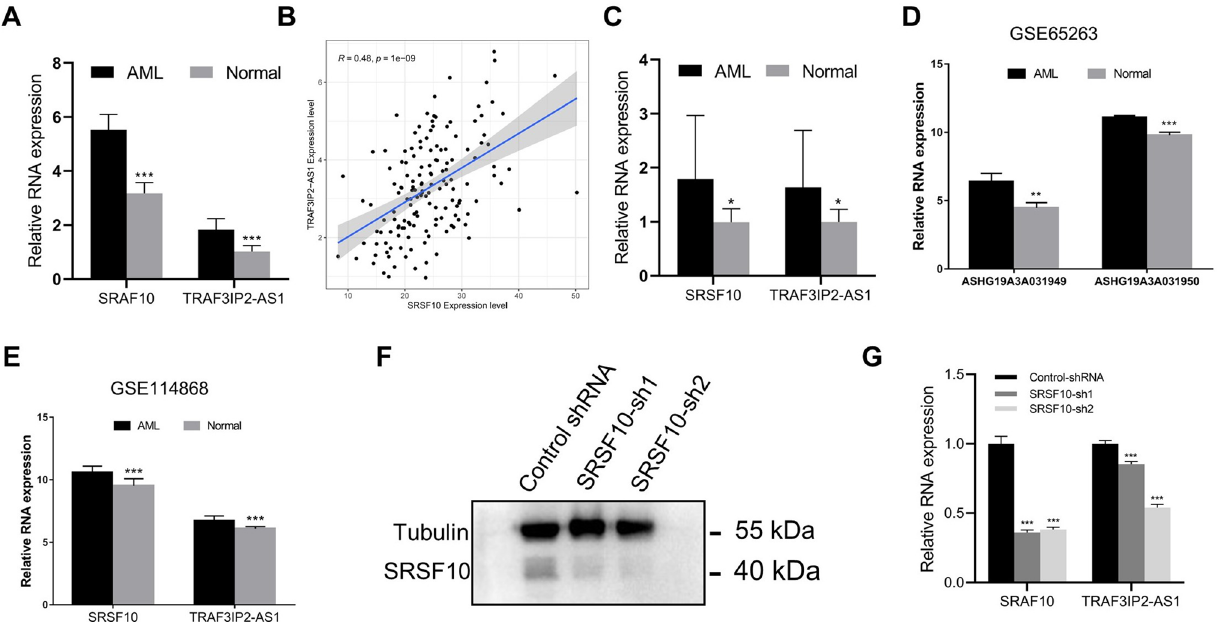
Figure 12. Interaction between SRSF10 and TRAF3IP2. ( A ) The levels of expression of SRSF10 and TRAF3IP2-AS1 in AML samples from the TCGA databases and normal samples from the GTEx databases. ( B ) Correlation analysis between SRSF10 and TRAF3IP2-AS1 in AML samples from the TCGA database. ( C ) The expression levels of SRSF10 and TRAF3IP2-AS1 in AML peripheral blood samples (n = 15) and normal human peripheral blood samples (n = 15). ( D , E ) SRSF10 and TRAF3IP2-AS1 expression levels in AML patient samples and normal samples in GEO chip data (ASHG19A3A031949: TRAF3IP2-AS1 transcript variants 1 and 3, ASHG19A3A031949: TRAF3IP2-AS1 transcript variants 1 and 2). ( F ) SRSF10 protein expression level in control shRNA and SRSF10-sh THP1 cells. ( G ) SRSF10 and TRAF3IP2-AS1 RNA expression levels in control shRNA and SRSF10-sh THP1